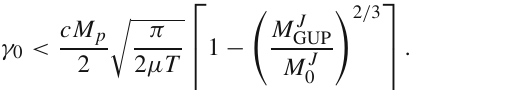
and Jeans mass M J of Bok globules, γ 0 and γ 2 are the first power and second power of the upper 0 GUP 0 is the upper bound on the GUP parameter of the KMM 0